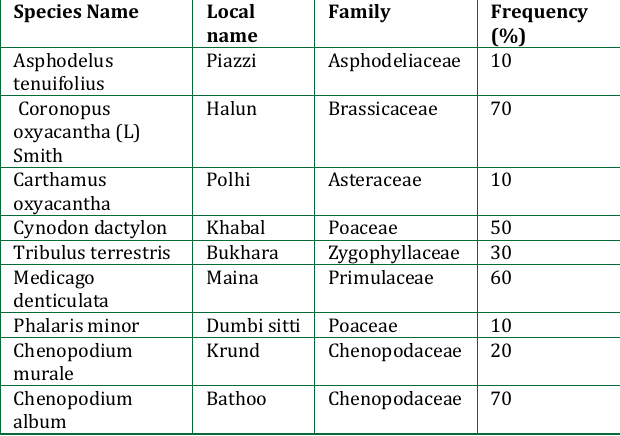
Table 3: Frequency (%) of weeds infesting wheat field at Fethpur district Layyah Species Name